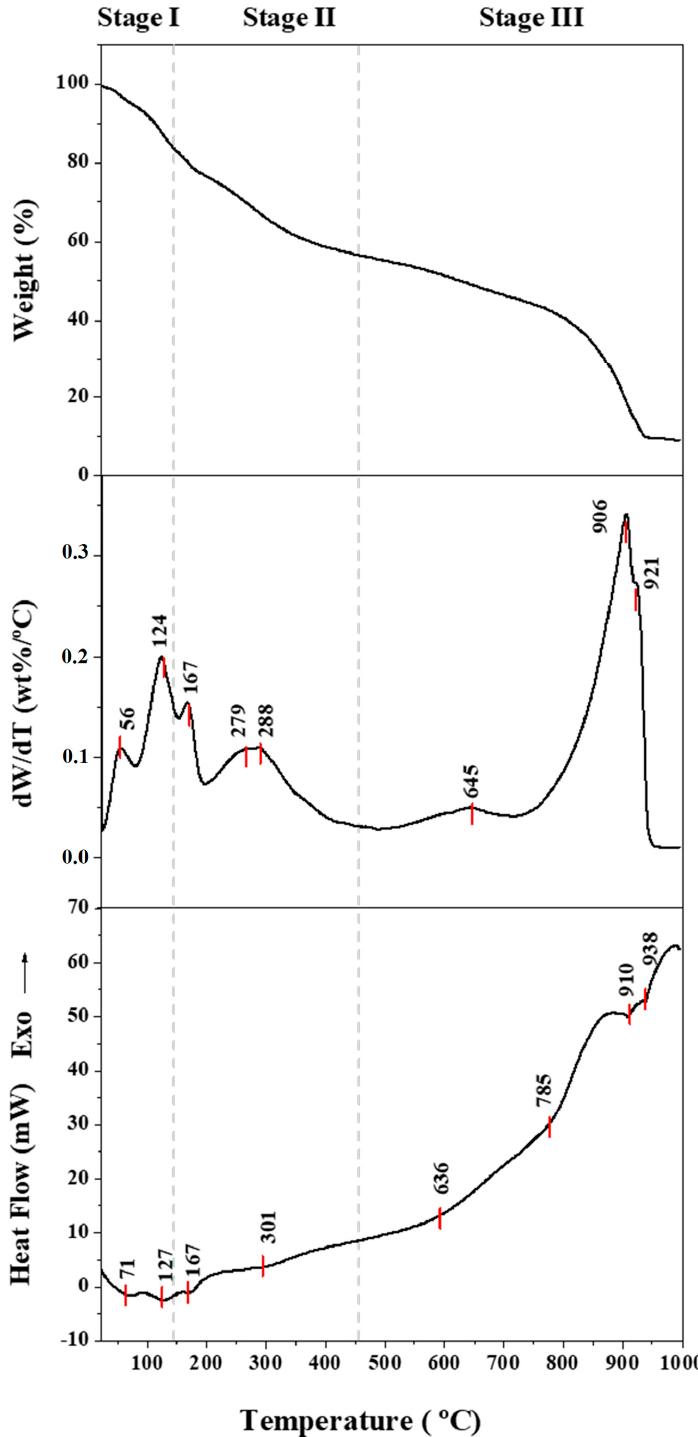
Figure 2. Thermogravimetric (TG), differential thermal analysis (DTG), and differential scanning calorimetry (DSC) curves. The predominant thermal peak around 900 °C is markedly different from previous reports. The DTG curve shows common decomposition steps related with HCN-derived polymers. However, the peak at 167 ◦ C and the peaks around 900 ◦ C are unique of our sample. The DSC curve shows multiple thermal decomposition steps. In general, each peak has its corresponding peak in the DTG